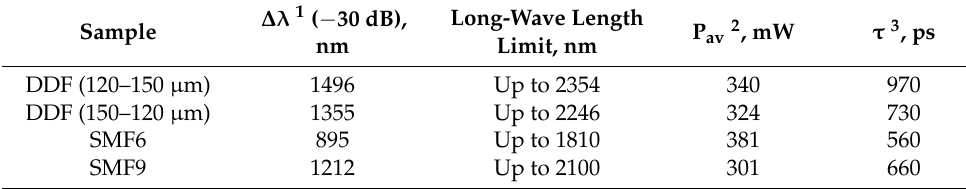
Table 2. The comparison of output parameters depending on the sample used.